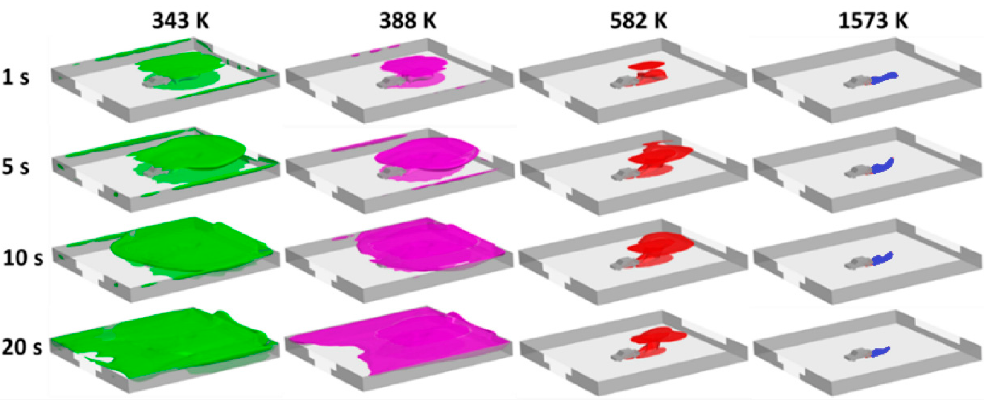
Figure 13. Iso-surfaces showing no-harm (343 K), pain (388 K), fatality (582) limits and visible flame temperature (1573 K) for ignited hydrogen release in case 5 (TPRD = 2 mm, 30°angle downward release with tank blowdown and car body).